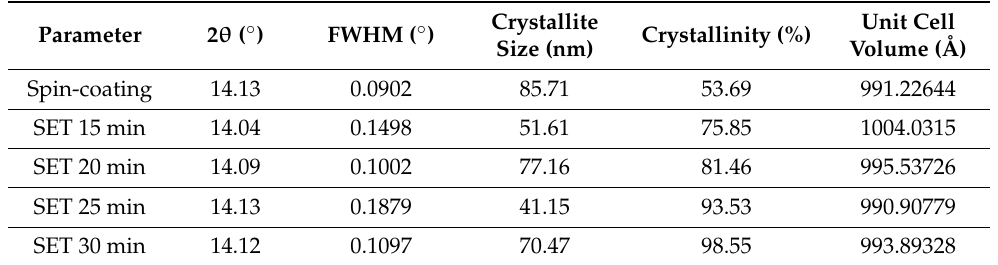
Table 3. Structural information of perovskite thin films for MAI (Spin-coating, SET)-PbCl 2 -MAI (SET) structure with different parameters for first